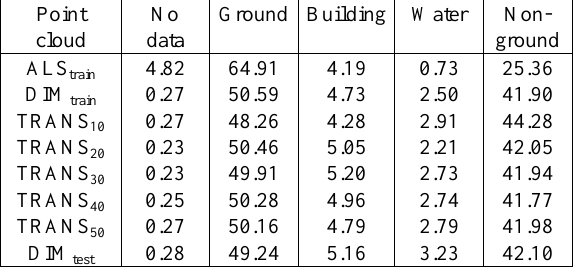
Table 1. Class distribution in the height image data [%]. ALS